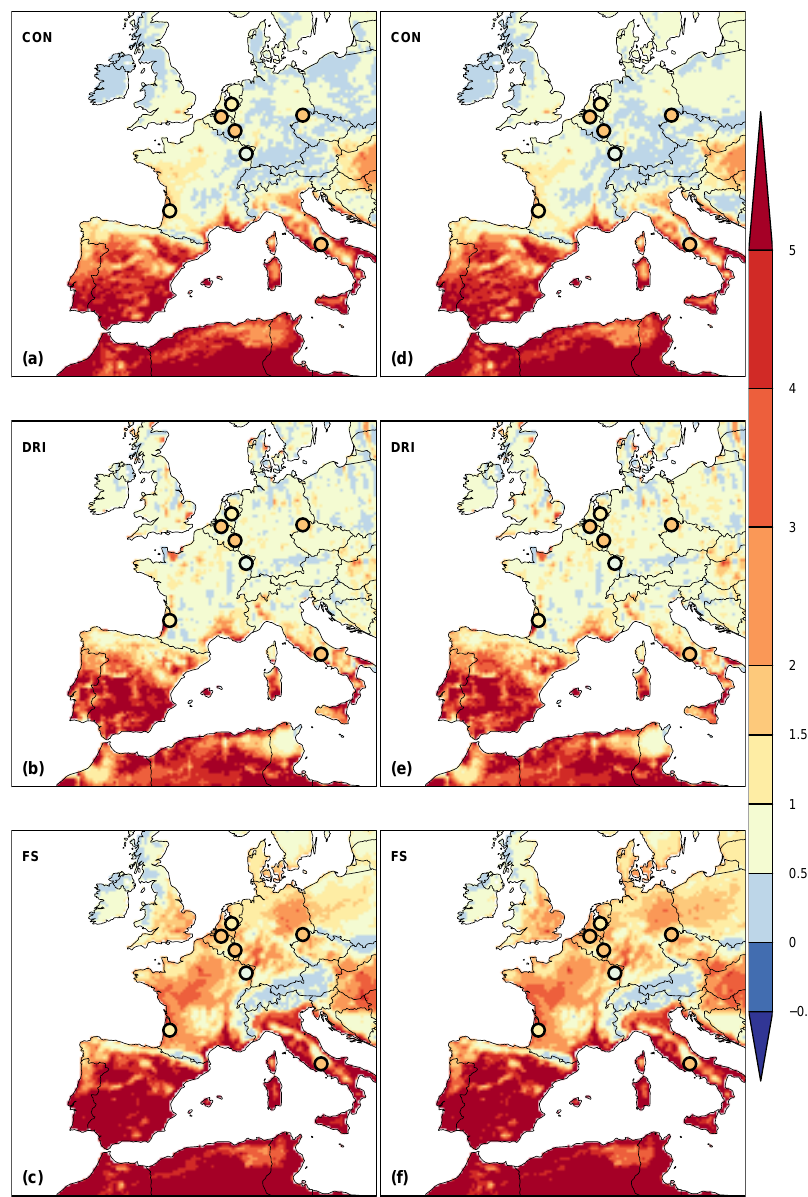
Figure 6. Daily maximum Bowen ratio averaged over the 5-year JJA period from 1996 to 2000 for (a) CON, (b) DRI and (c) FS and averaged over the 10-year JJA period 1991–2000 for (d) CON, (e) DRI and (f) FS. The dots represent the values for the FLUXNET stations